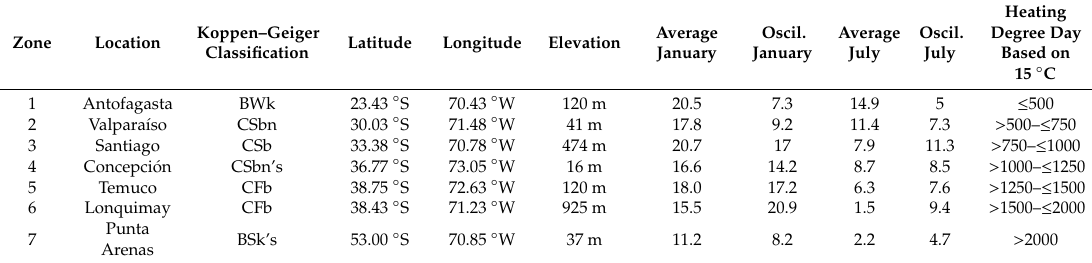
Table 5. Selected locations from Chilean Climatic Zoning.